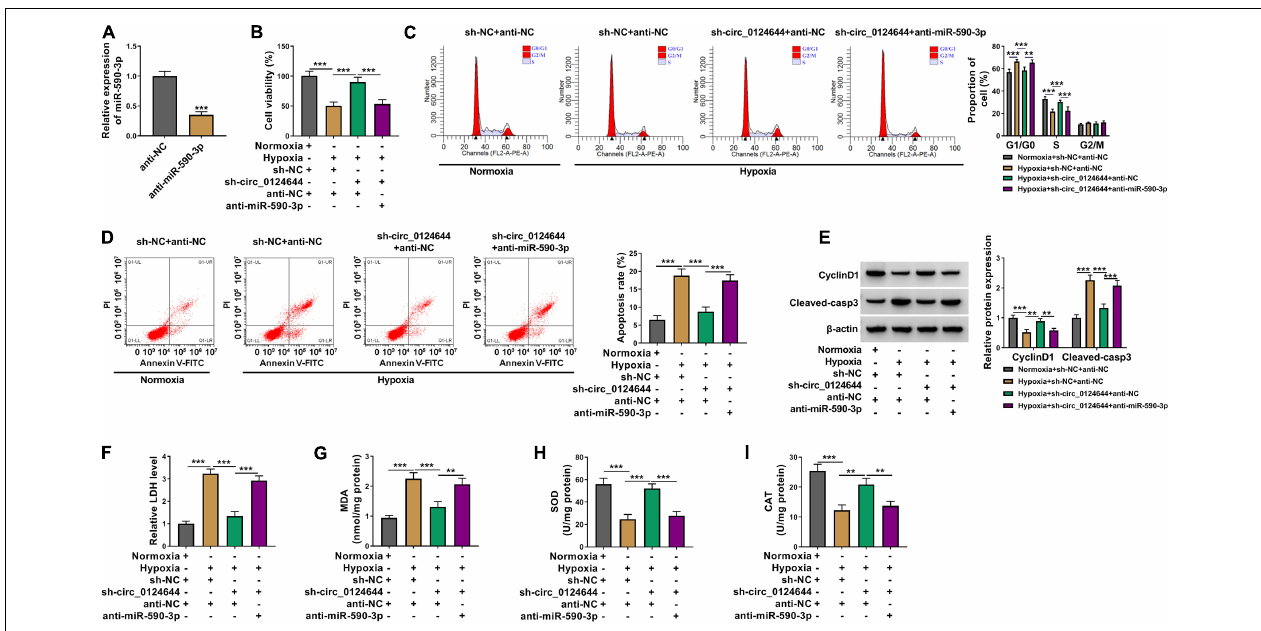
FIGURE 5 | Effects of miR-590-3p inhibitor and circ_0124644 silencing on hypoxia-induced cardiomyocytes injury. (A) AC16 cells were transfected with anti-NC or anti-miR-590-3p. MiR-590-3p expression was detected by qRT-PCR. (B–I) AC16 cells were transfected with sh-NC + anti-NC, sh-circ_0124644 + anti-NC, sh-circ_0124644 + anti-miR-590-3p, followed by treated with hypoxia. Normoxia-treated AC16 cells transfected with sh-NC + anti-NC were used as control. (B) CCK8 assay was employed to measure cell viability. (C,D) Cell cycle distribution and cell apoptosis were evaluated using flow cytometry. (E) The protein levels of CyclinD1 and Cleaved-casp3 were examined by WB analysis. (F–I) The levels of LDH, MDA, SOD, and CAT were analyzed by corresponding Assay Kits. ** P < 0.01, *** P <